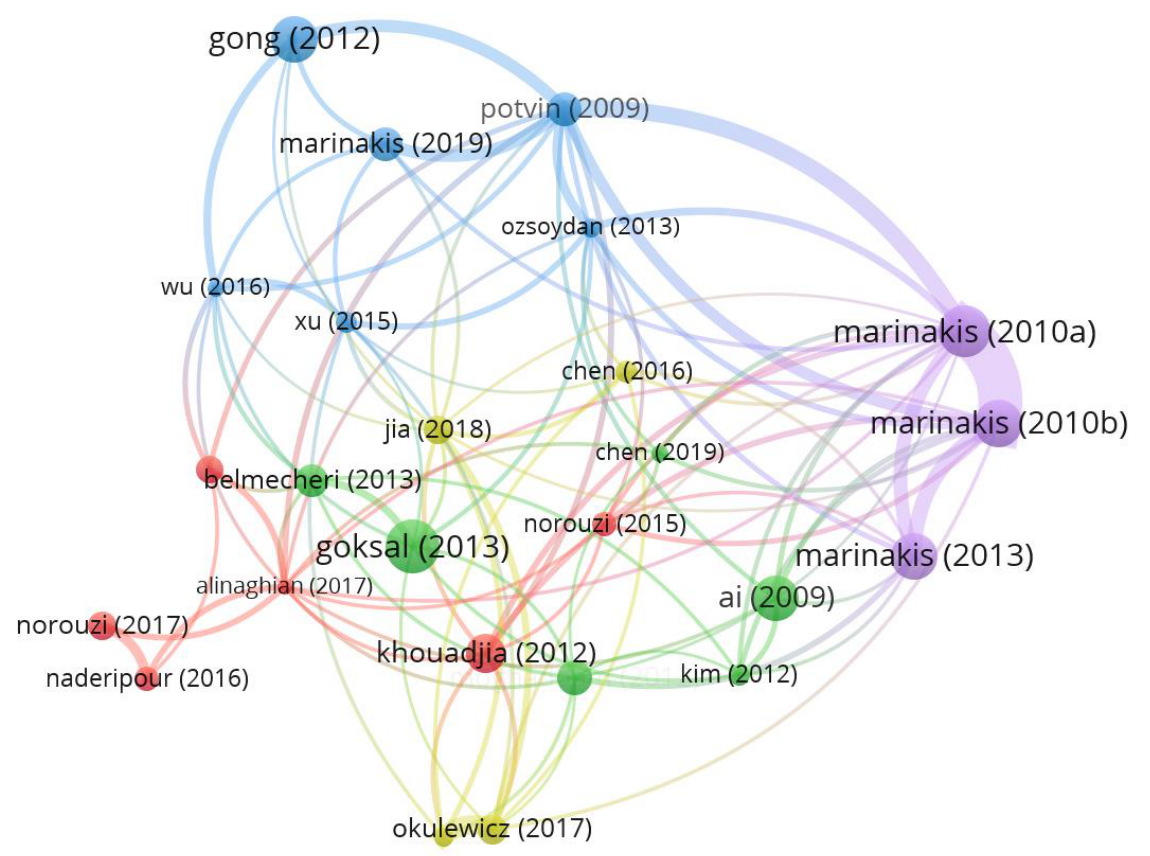
Figure 12. Bibliographic coupling documents network for the Web of Science database search, 10